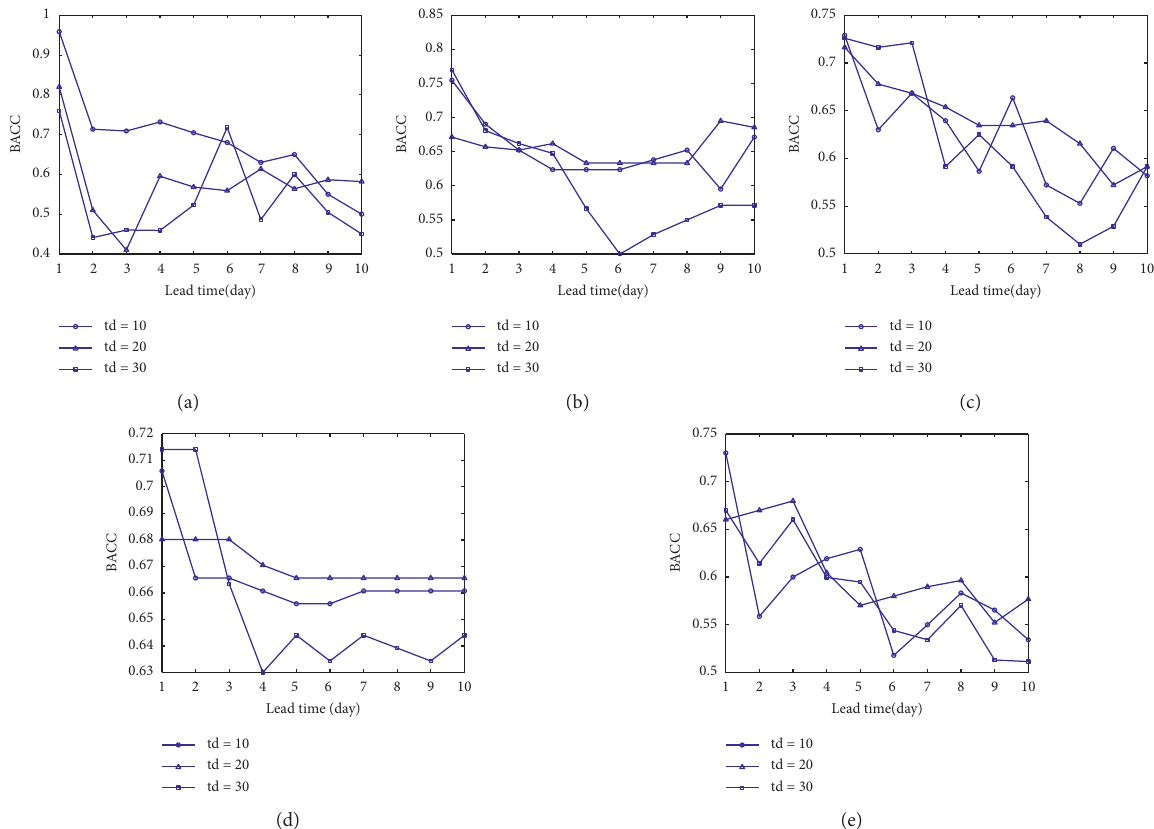
Figure 9: Sensitivity analysis on lead times Δ t